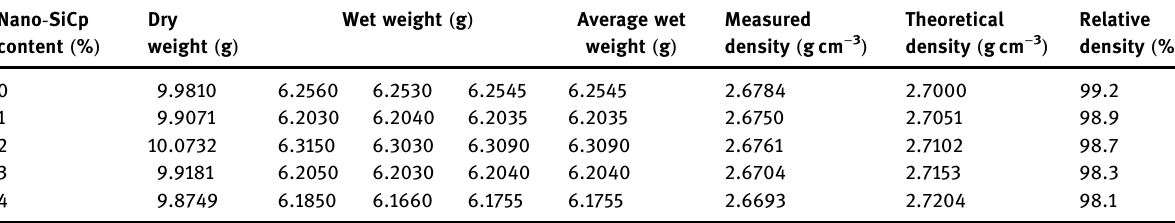
Table 2: Relative density of nano - SiCp/Al – 7Si composites with di ff erent SiCp volume fraction Nano -